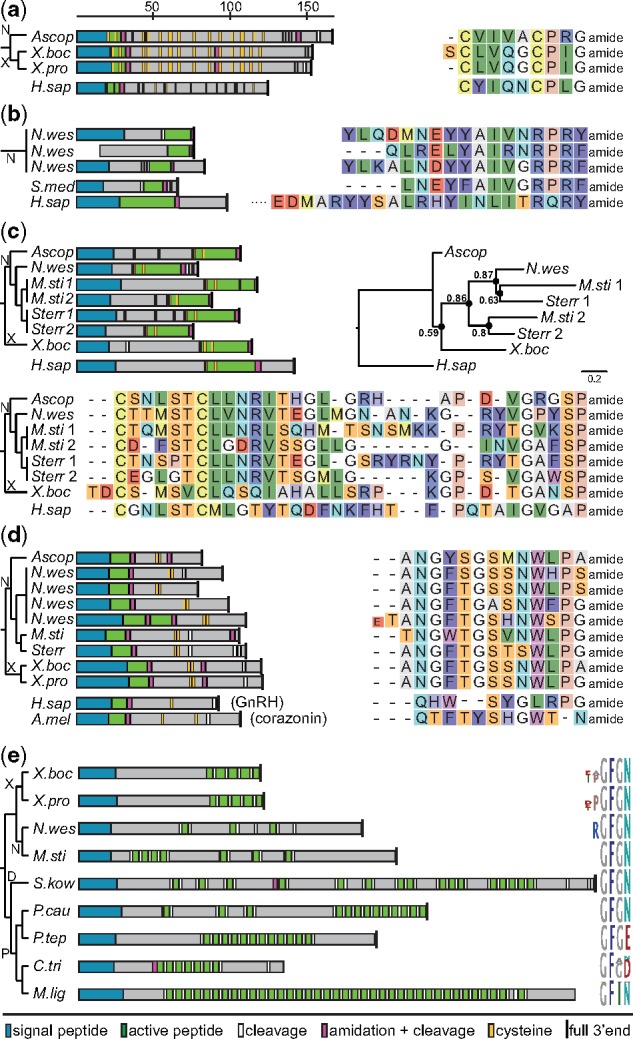
Xenacoelomorph orthologs of bilaterian neuropeptides. (a) Vasotocin-neurophysin precursor schemes and vasotocin sequences. (b) Neuropeptide Y/F precursor diagrams and active peptide sequences. (c) Calcitonin precursor schemes, phylogenetic FastTree analysis of predicted active ligands and alignment of predicted active peptides. (d) GnRH/corazonin related peptide precursor diagrams and predicted active ligands. (e) Achatin precursor schemes and peptide sequence logo of xenacoelomorph and nephrozoan sequences. D, Deuterostomia; N, Nemertodermatida; P, Protostomia; X, Xenoturbella; A.mel, Apis mellifera; Ascop, Ascoparia sp.; C.tri, Charonia tritonis; H.sap, Homo sapiens; M.lig, Macrostomum lignano; M.sti, Meara stichopi; N.wes, Nemertoderma westbladi; P.tep, Parasteatoda tepidariorum; P.cau, Priapulus caudatus; S.kow, Saccoglossus kowalevskii; S.med, Schmidtea mediterranea; Sterr, Sterreria sp.; X.boc, Xenoturbella bocki; X.pro, Xenoturbella profunda. Scale bar on the top indicates length of neuropeptide precursors in number of amino acids. Color coding of amino acid residues of the sequences is according to their biochemical properties (i.e., Rasmol coloring).